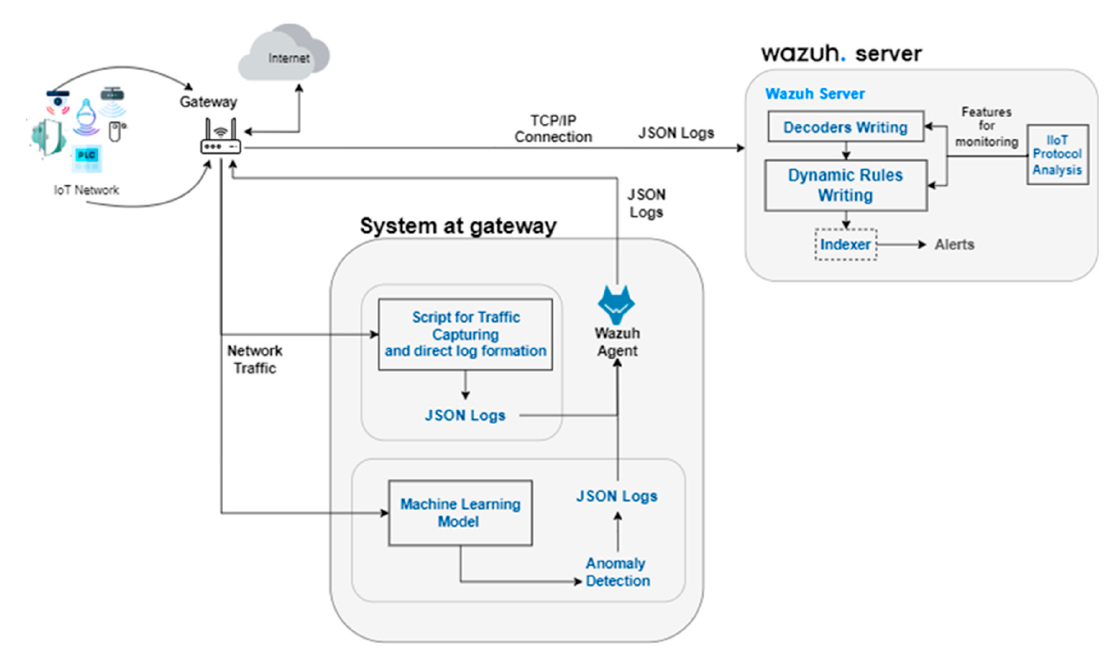
Figure 6. The Proposed Security Scheme.